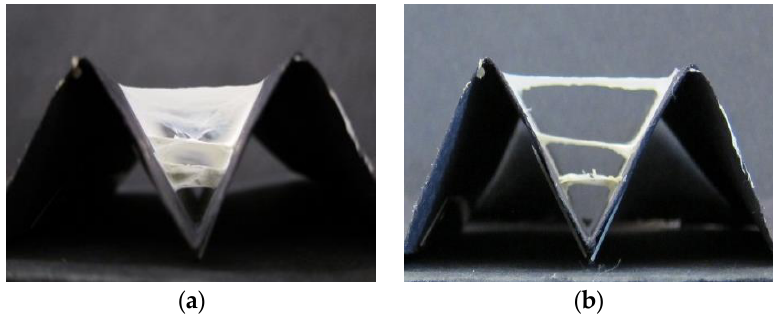
Figure 10. Photographic images showing three nanofiber bridges between the two walls of V-shaped substrate (variation D): ( a ) directly after electrospinning and ( b ) after removing nanofibers in front manually using a cosmetic stick.